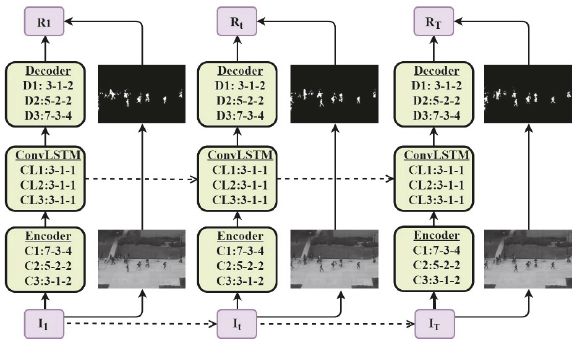
Figure 2: Structure of the proposed WCAE-LSTM